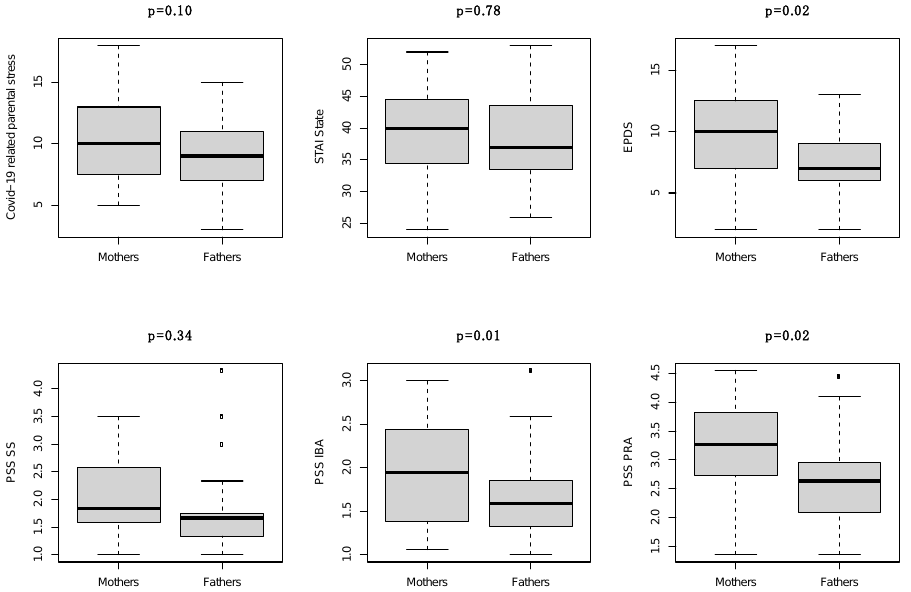
Figure 4. Comparison of COVID-19 related parental stress, STAI State, EPDS, PSS-SS, PSS-IBA and PSS-PRA between fathers and mothers of the same